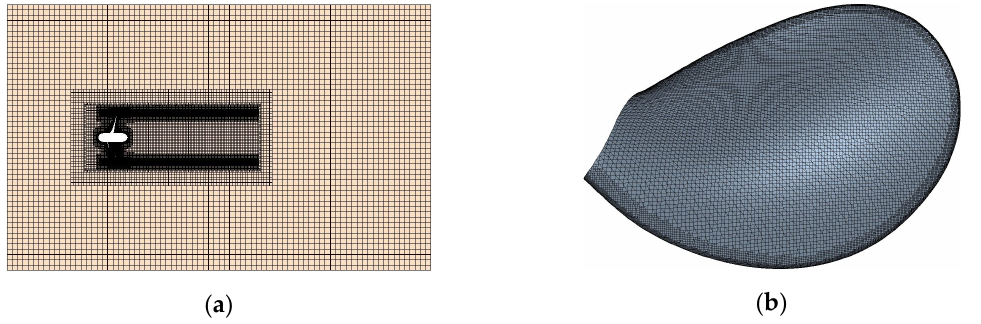
Figure 2. Mesh characteristics: ( a ) whole computational domain and ( b ) blade surface.